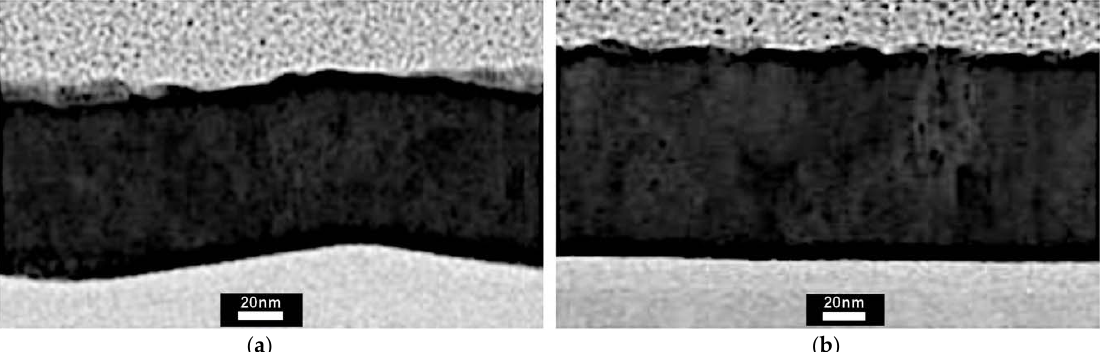
Figure 2. STEM image of the samples produced by Pt–C and Pt targets sputtering using DC regime with pulsed bias voltage of − 200 V (pulsed frequency 10 kHz) applied to the substrate. ( a ) Pt-C film deposited on Ti substrate. ( b ) Pt film deposited on Ti substrate. Scale bar 20 nm.